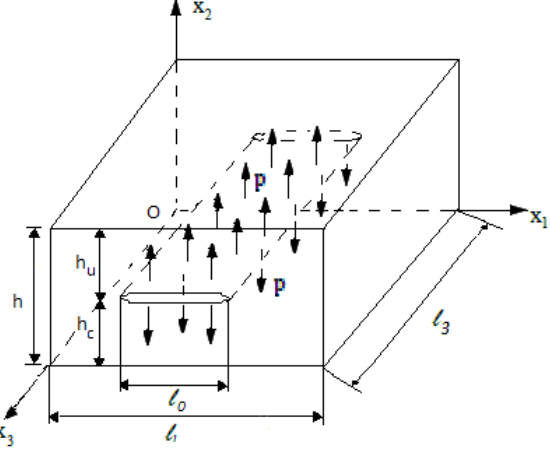
Figure 1: Geometry of a rectangular plate with a band